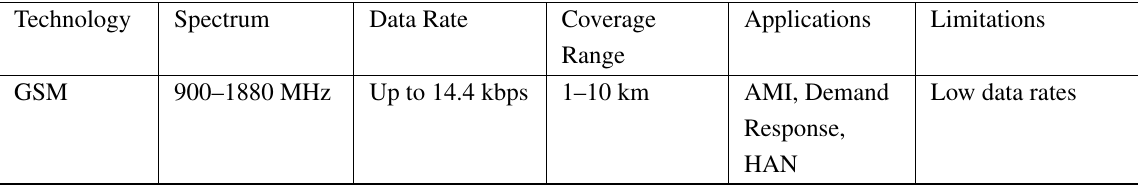
Table 1. Smart grid communication technologies (Gungor et al.